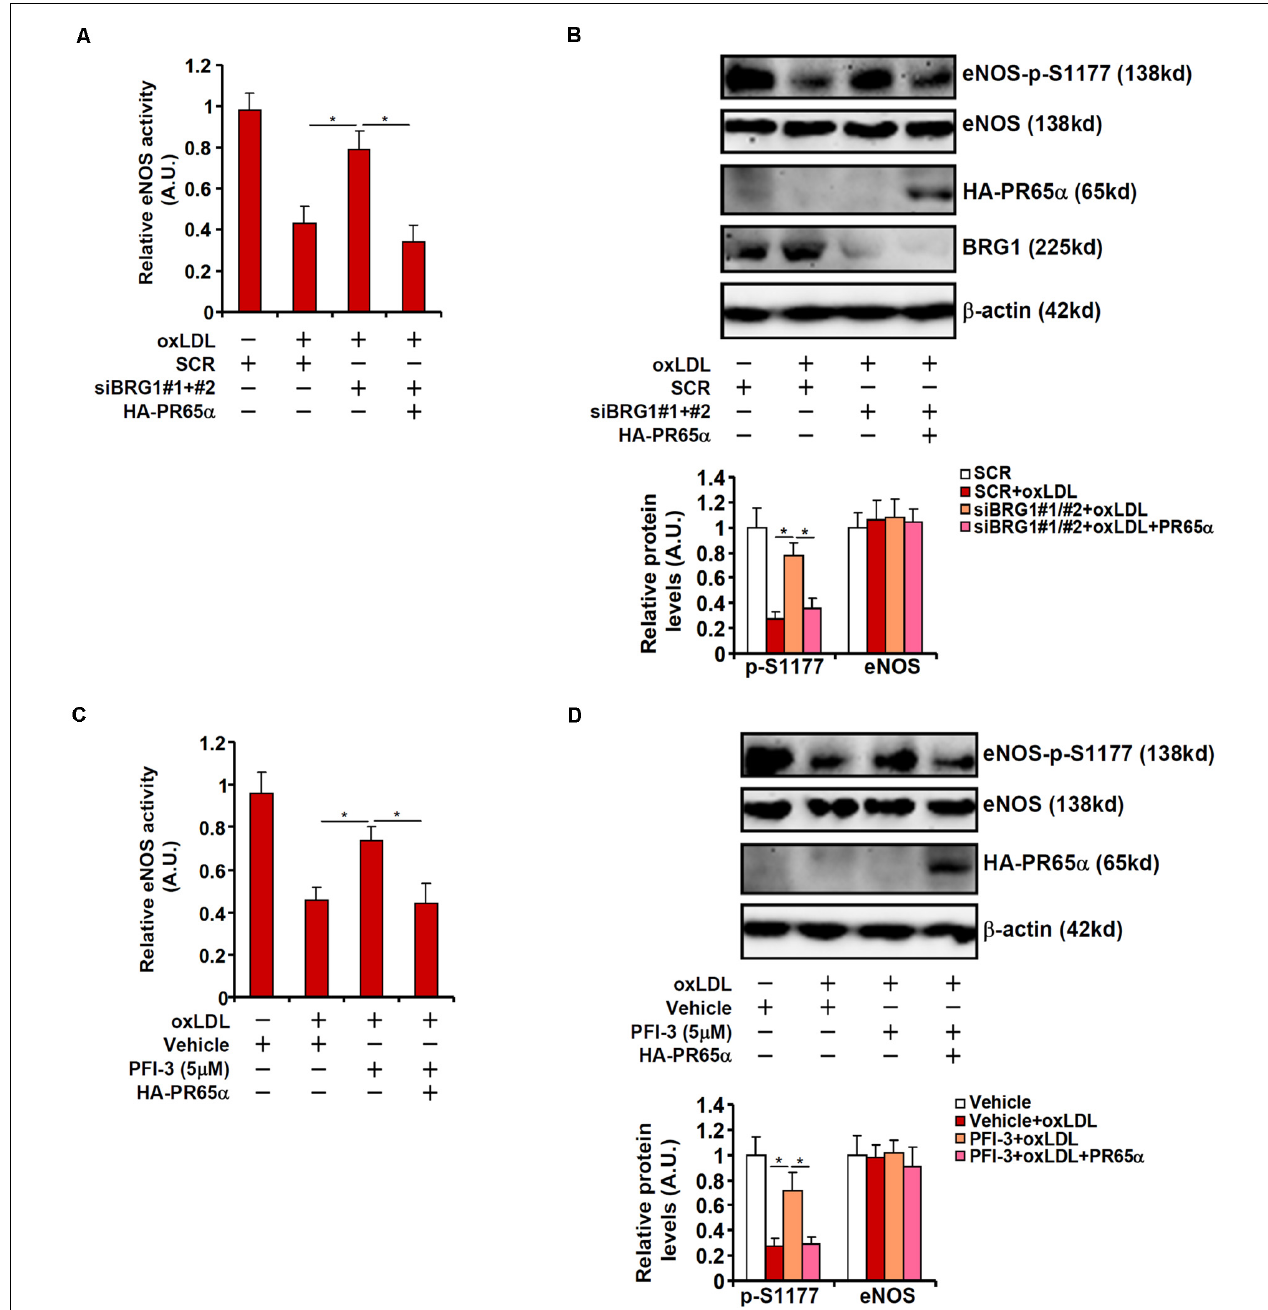
FIGURE 4 | PP2A over-expression circumvents BRG1 deficiency to suppress NO production. (A,B) EAhy296 cells were transfected with siRNA targeting BRG1 in the presence or absence of exogenous HA-tagged PR65 α followed by treatment with oxLDL (10 µ g/ml) for 24 h. NO content in the culture media was examined by the Griess assay. eNOS phosphorylation was examined by Western. (C,D) EAhy296 cells were transfected with exogenous HA-tagged PR65 α followed by treatment with oxLDL (10 µ g/ml) and PFI-3 (5 µ M) for 24 h. NO content in the culture media was examined by the Griess assay. eNOS phosphorylation was examined by Western. * p <